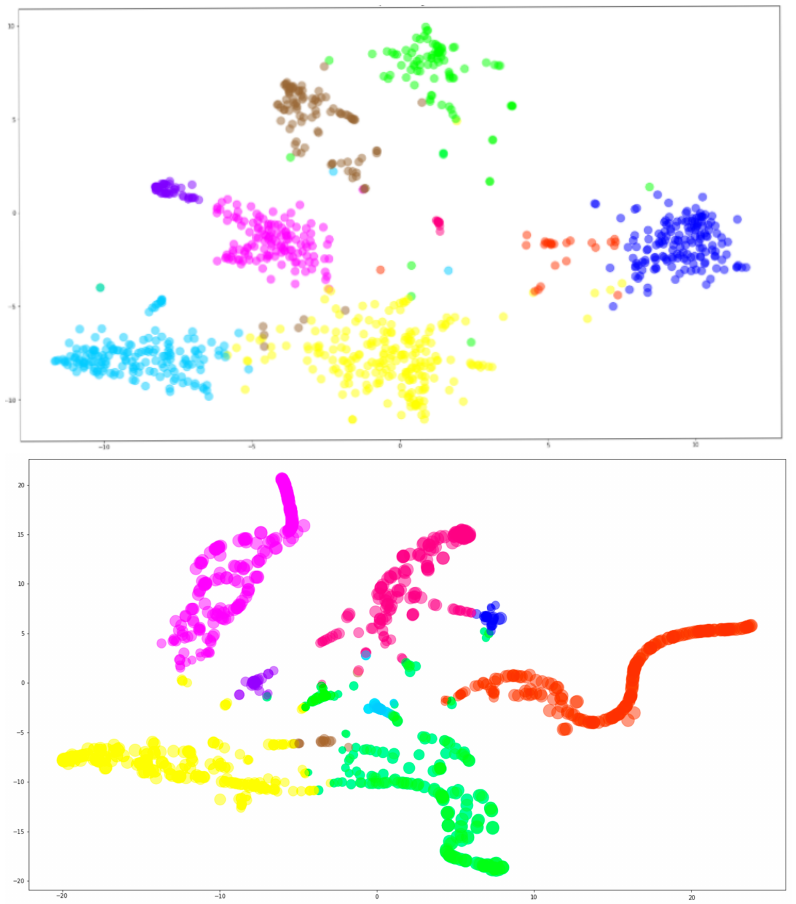
Figure 15. D1 t-SNE representation, TF-IDF weighting scheme, K = 10, joint-approach ( top ) and probabilistic approach ( bottom